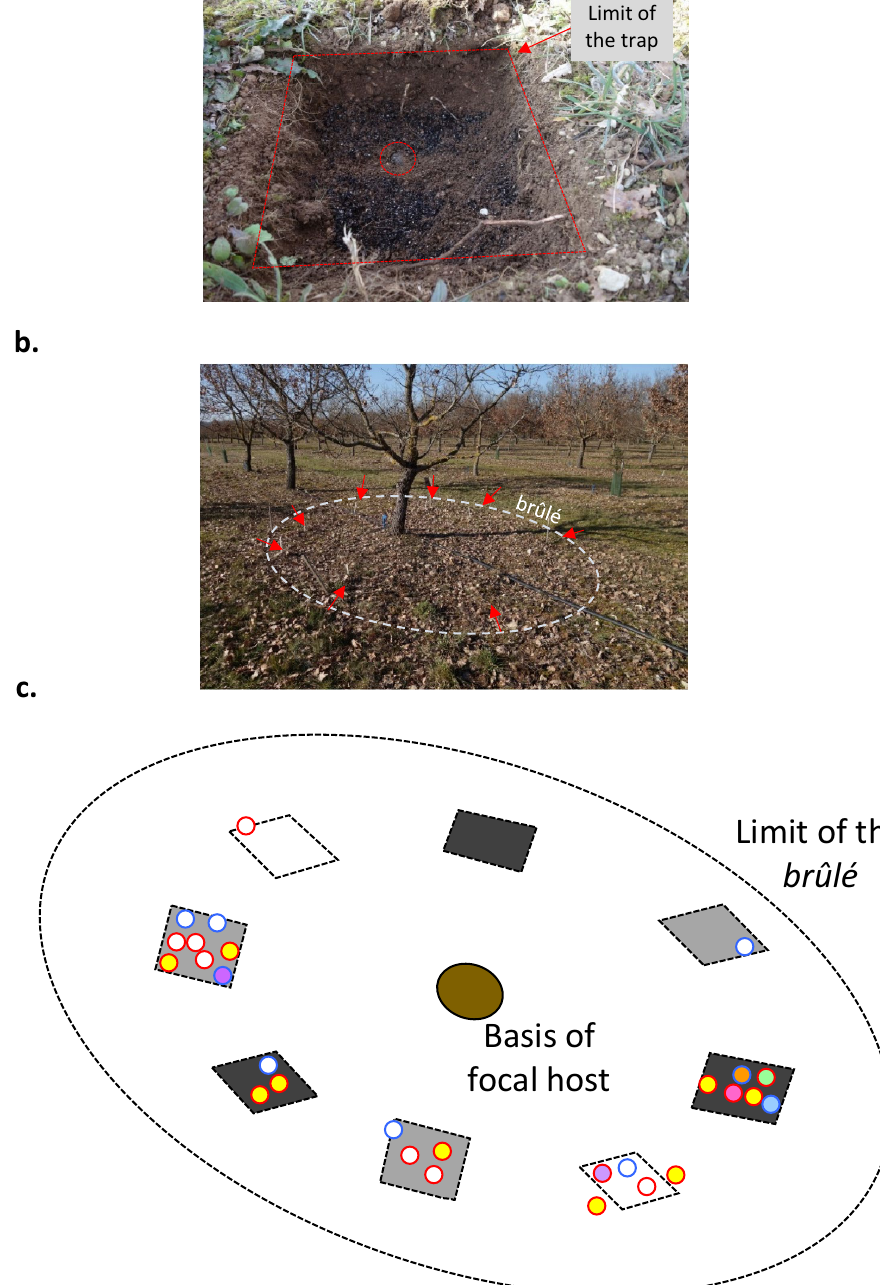
Figure 3. ( a ) View of a truffle trap at final collecting time, with indication of the limit of the trap (dotted white line) and the position of a fruitbody developed at its ground (red circle). Photo credit F. Richard ( b ) View of experimental device after two years and before collecting fruitbodies showing the position of experimental traps (red arrows) all around the host tree within the brûlé . Photo credit F. Richard ( c ) Schematic representation of a brûlé on site 2 (Jonzac), localizing harvested fruitbodies (circles) in- or outside of non-inoculated traps (white) versus traps inoculated with one mating type gleba (light grey) versus with two mating type glebas (dark grey), and distinguishing the multilocus maternal genotypes according to the color of circle inside -(white indicates non identified MLGs) and the mating type of the gleba according to the color of circle outline (maternal individual; Mat 1-1 circled in blue and Mat 1-2-1 in red). All identified paternal MLGs were different, and are not represented for easiness of